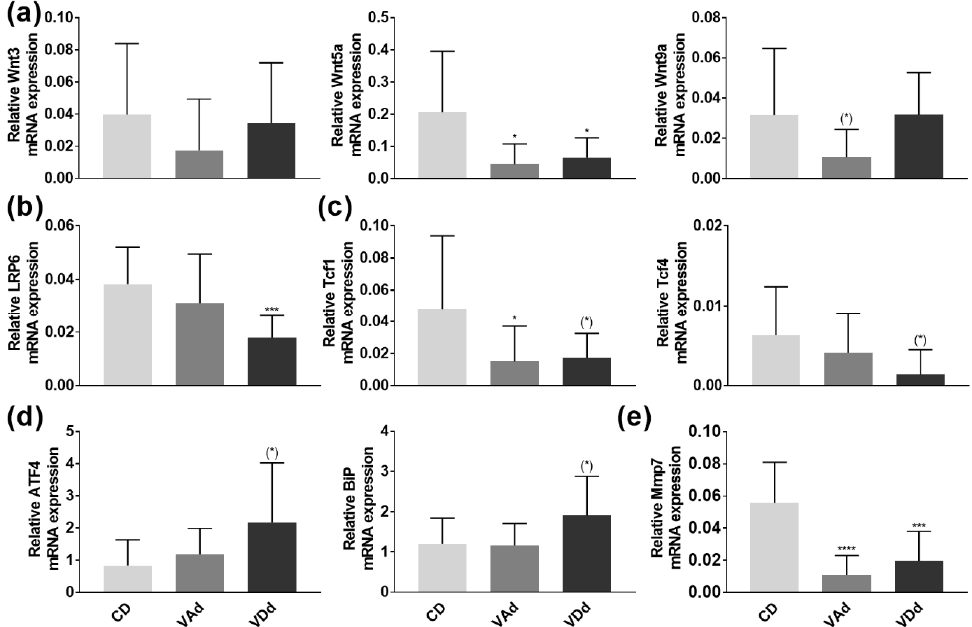
Figure 3. Vitamin-deficient diets disturb AMP formation through Wnt, ER stress and Mmp7. mRNA expression levels of Wnt3, Wnt5a, Wnt9a ( a ), LRP6 ( b ), Tcf1, Tcf4 ( c ) ATF4, BiP ( d ) and Mmp7 ( e ) in the ileum determined by quantitative RT-PCR. Data are shown as means +/ − standard error of the mean ( n = 8–12). Statistical analysis was performed by one-way ANOVA with Sidak´s post-test. Significant differences are indicated: * p -value < 0.05; *** p -value < 0.001; **** p -value < 0.0001. Abbreviations: Wnt, wingless and Int; LRP6, low-density-lipoprotein receptor-related protein 6; Tcf, T cell-specific transcription factor; ATF4, activating transcription factor 4; BiP, chaperone protein-binding protein; Mmp7, peroxisome proliferator-activated receptor gamma; for other abbreviations, see Figure 1.